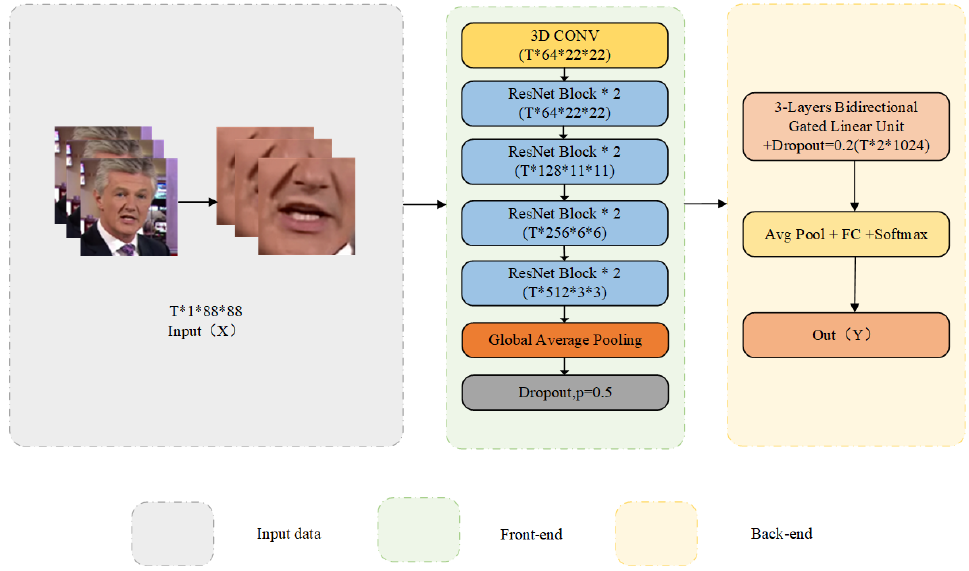
Figure 4. Baseline model of this